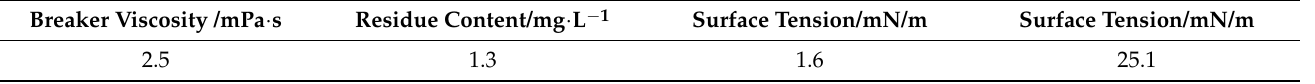
Table 7. Gel breaking performance of gel fracturing